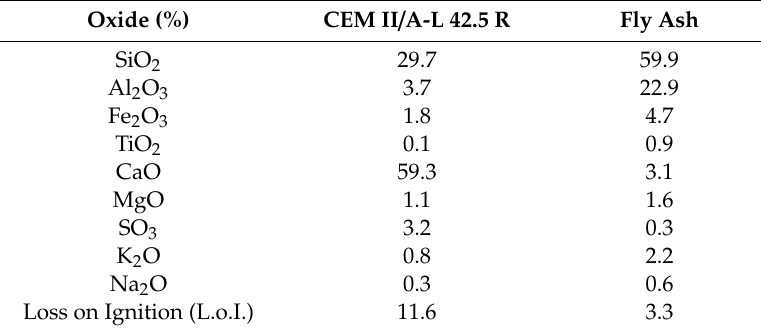
Table 1. Chemical composition of cement and fly